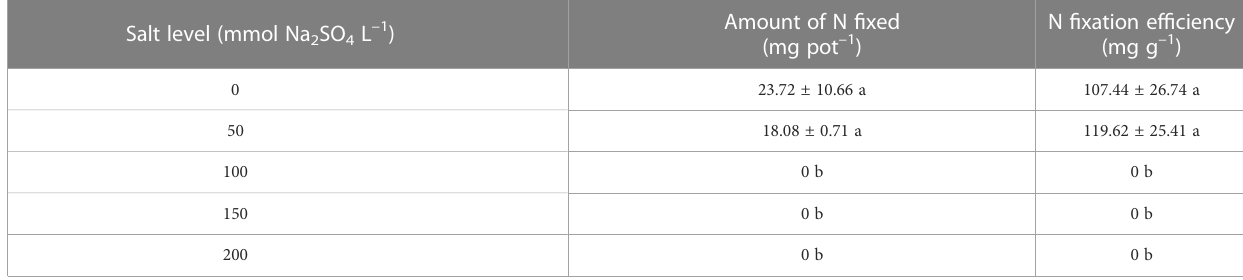
Values are means (n = 4) ± SD. Different letters represent a signi fi cant difference among different salt levels (p ≤ 0.05).